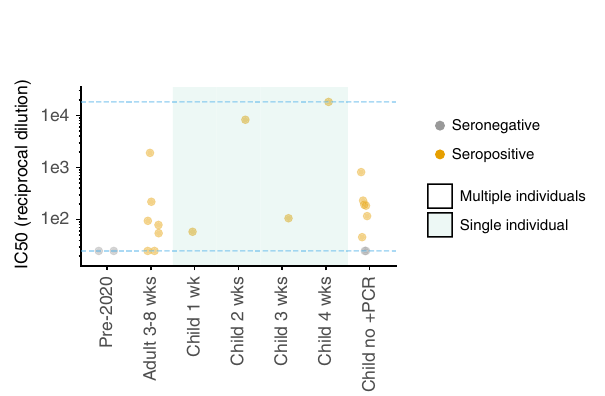
Fig. 3 Neutralizing activity of sera against spike-pseudotyped lentiviral particles. The y axis is reciprocal dilution of serum that inhibits infection by 50% (IC 50 ). Dashed blue lines are the limits of dilution series; points at those limits are lower or upper bounds. The child sera shown here are from the same individuals as in Fig. 1b; the two seronegative “ child no + PCR ” samples are the two ELISA + , Abbott CMIA − samples. Shaded categories indicate single individuals, as in Fig. 1b. Full curves are in Supplementary Fig.